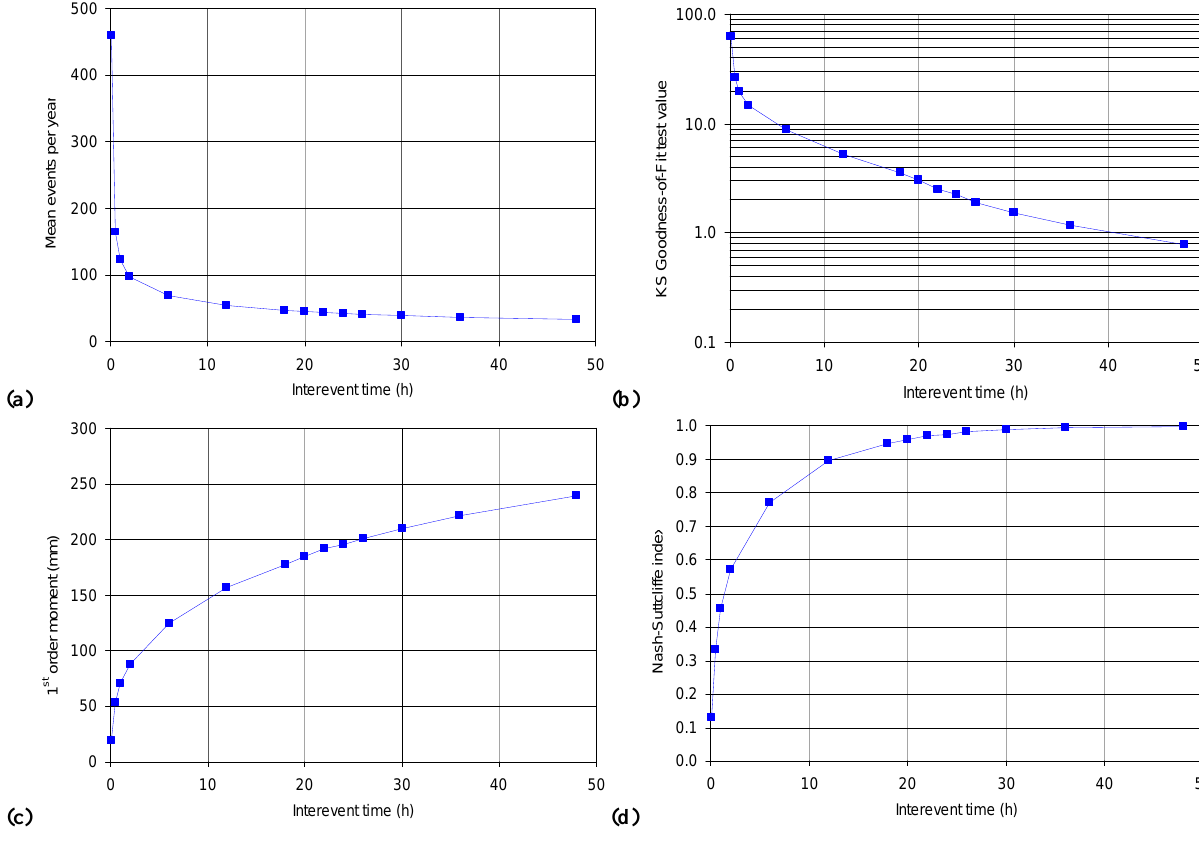
Fig. 4. Decision parameter evolution for critical interevent time